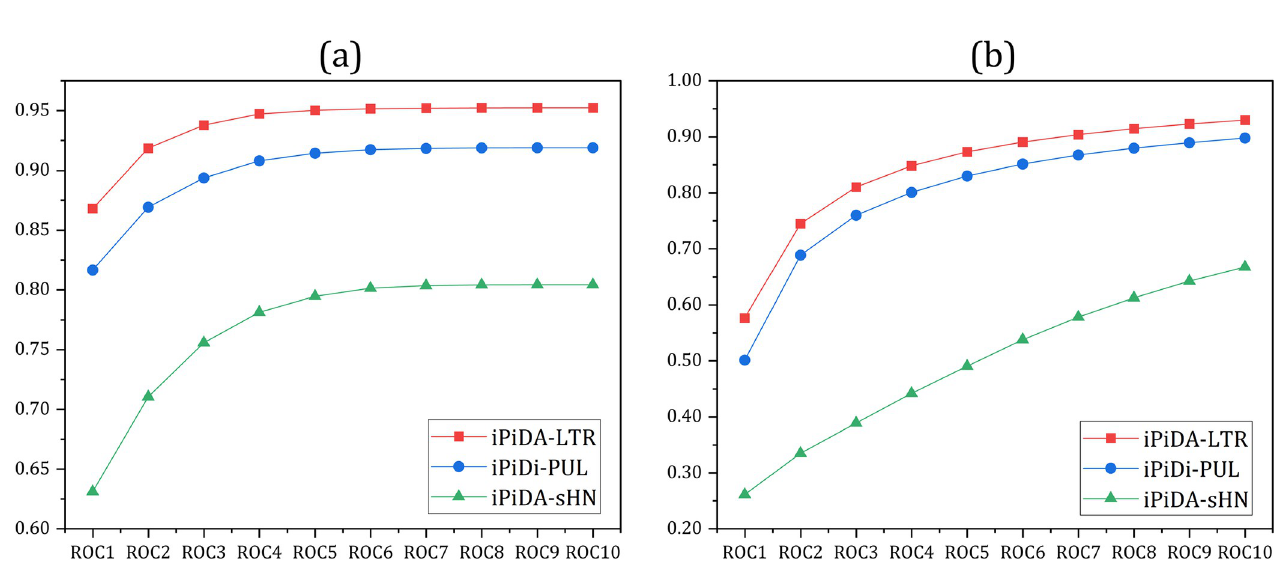
Fig 6. The comparison results of different methods. (a) and (b) are based on S a